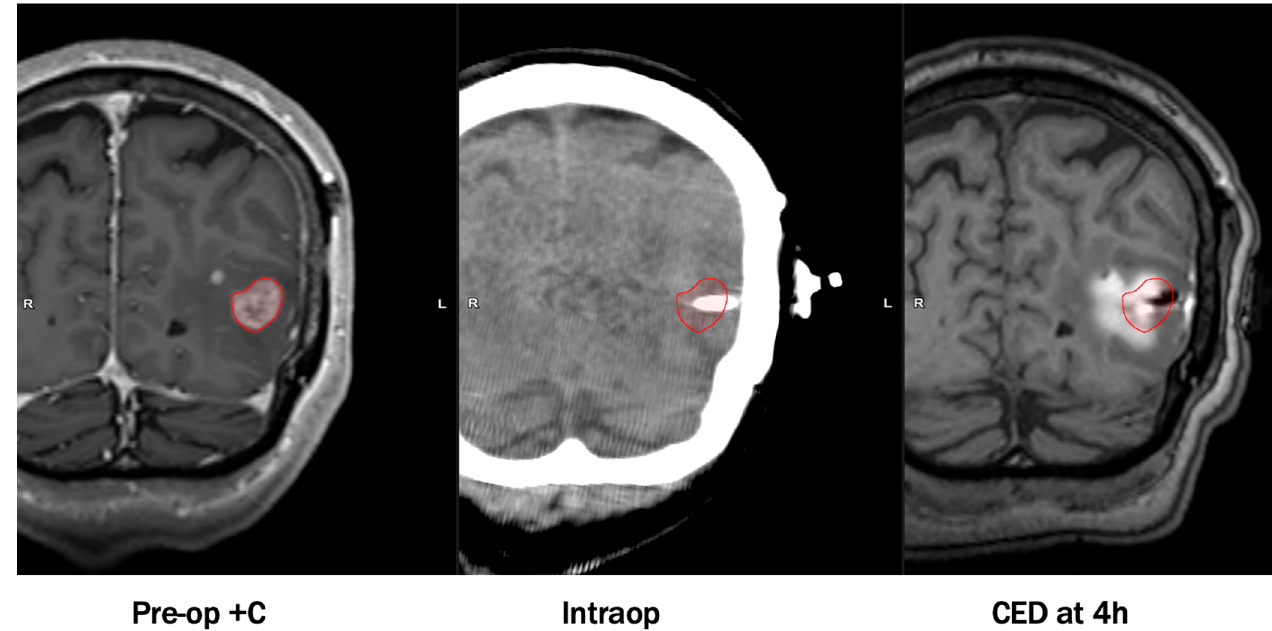
Figure 1. An example of an infusion performed by convection-enhanced delivery (CED) visualized on magnetic resonance imaging (MRI) with co-convected contrast. Images were obtained with permission from Dr. Michael Vogelbaum and Moffitt Cancer Center.